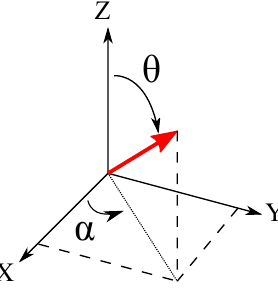
Figure 1: Inclination ( θ ) and azimuth ( α ) of a 3D vector